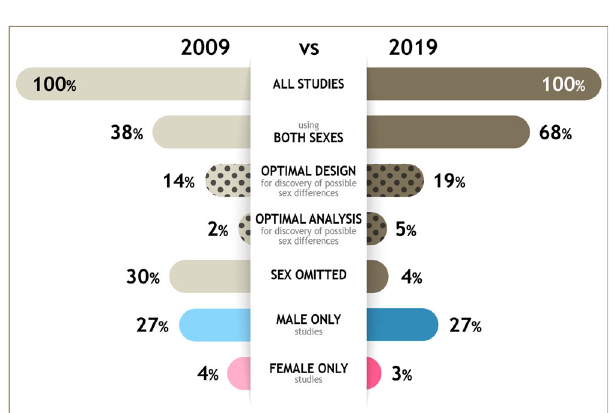
Fig. 6 An infographic depicting the change in percentages of total papers sampled reporting studies in 2009 and 2019 that used both sexes, a single sex, omitted sex, papers reporting studies that used an optimal design or analyses for the discovery of possible sex differences irrespective of discipline. Optimal design refers to relatively based sample size and use of males and females consistently across the experiments whereas optimal analyses refers to the use of sex as a discovery variable. Although the percentage of studies in the sample of neuroscience and psychiatry papers analysed has increased the use of optimal design and analyses has not changed as much and remain at low levels. There are nine times the percentage of male-only compared to female-only